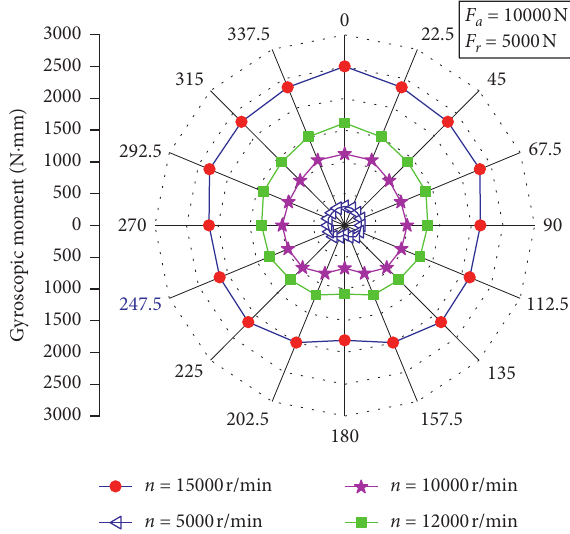
Figure 20: Contact force between ball and outer ring under axial force and radial force.